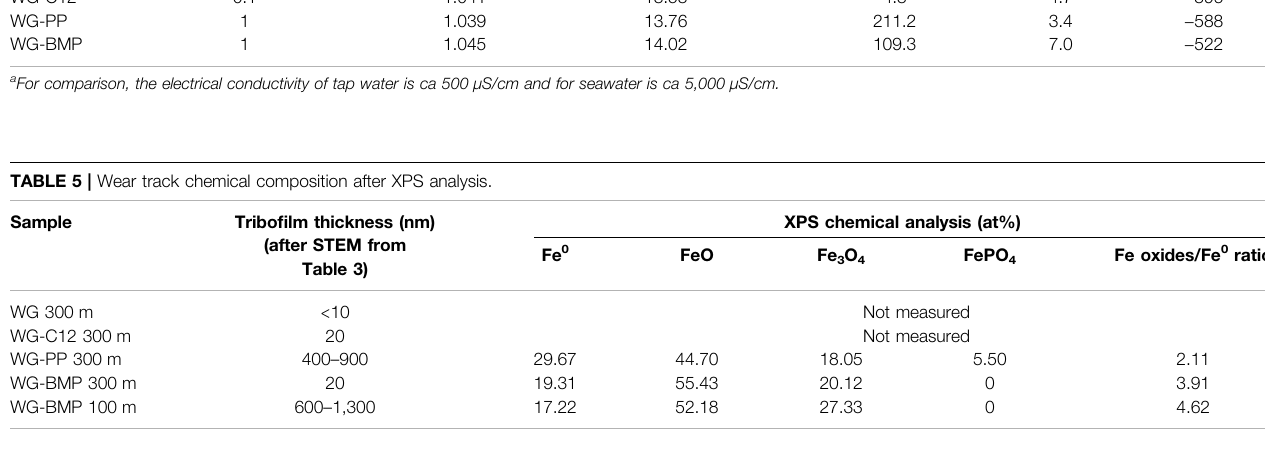
TABLE 4 | Physical and chemical properties of all lubricants. Lubricant Additive concentration Density (g/cm 3 ) Dynamic viscosity (wt%) (mPa.s)